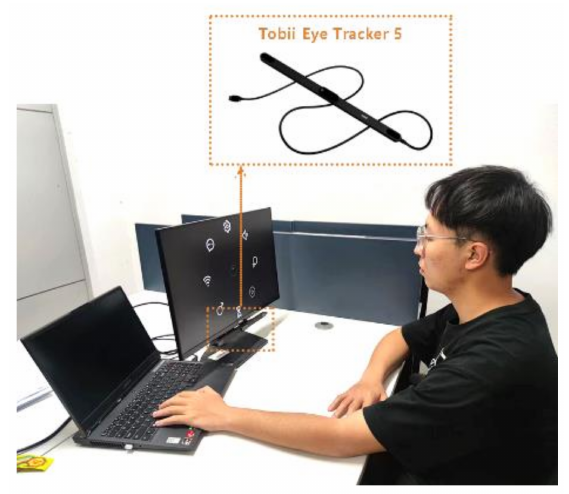
Figure 5. Experimental